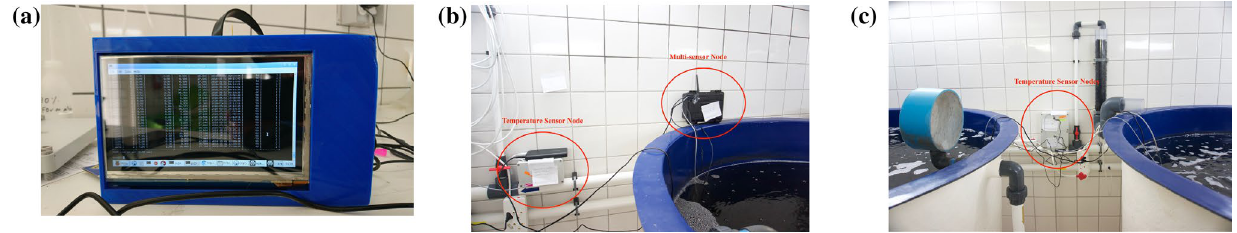
Fig. 2 Deployed nodes in the Mariculture Laboratory in Namibia. a Data collection node, b deployed multi-node and temperature node and c deployed temperature node